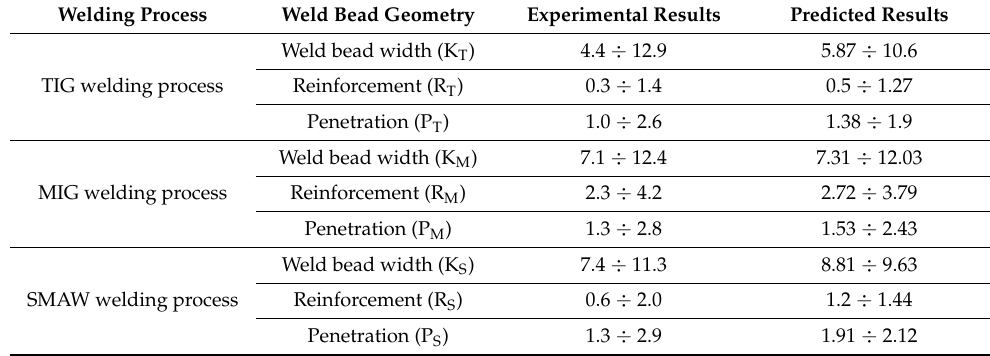
Table 13. Comparison of the values of the weld bead geometry between experiment and prediction. Welding